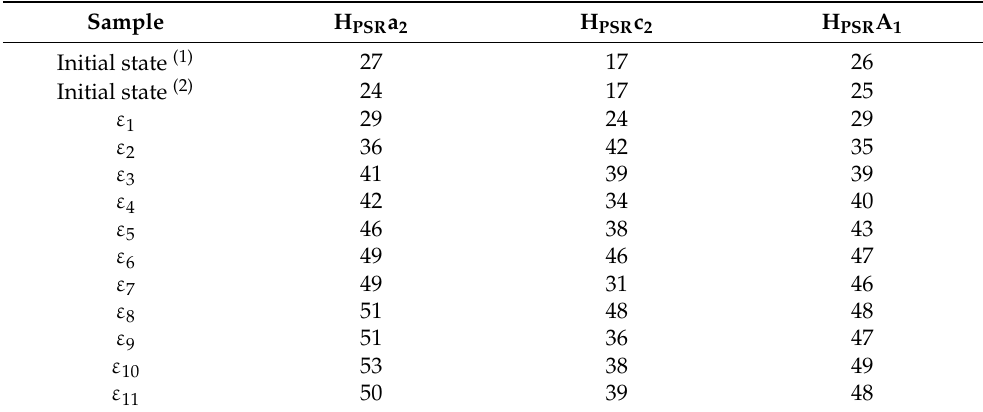
Table 6. The values of “true hardness”.